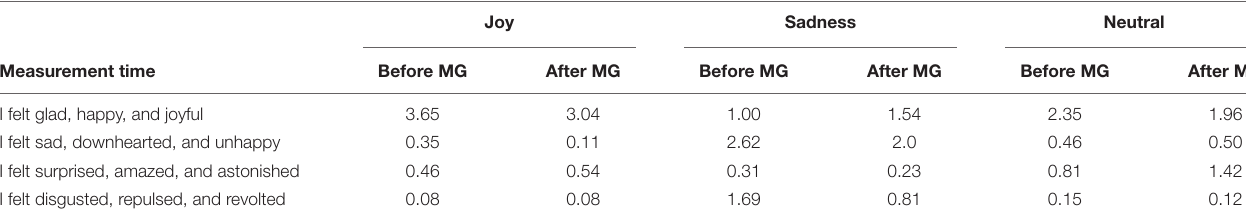
TABLE 1 | Mean scores for each question by emotional condition before and after the mirror game (MG). Joy Sadness Neutral Measurement time Before MG After MG Before MG After MG Before MG After